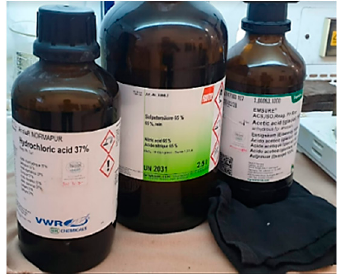
Figure 21. Reagent used to perform metallographic attack.